Question: What form of chart is displayed?
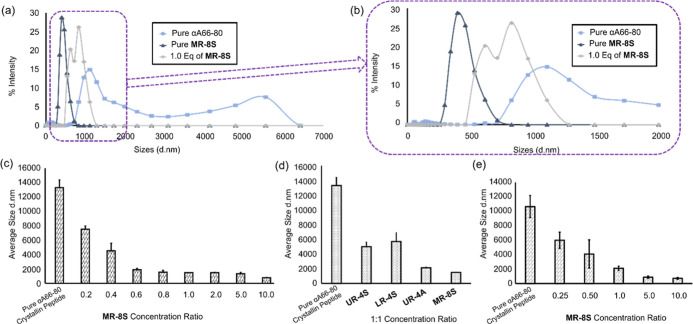
Answer: bar